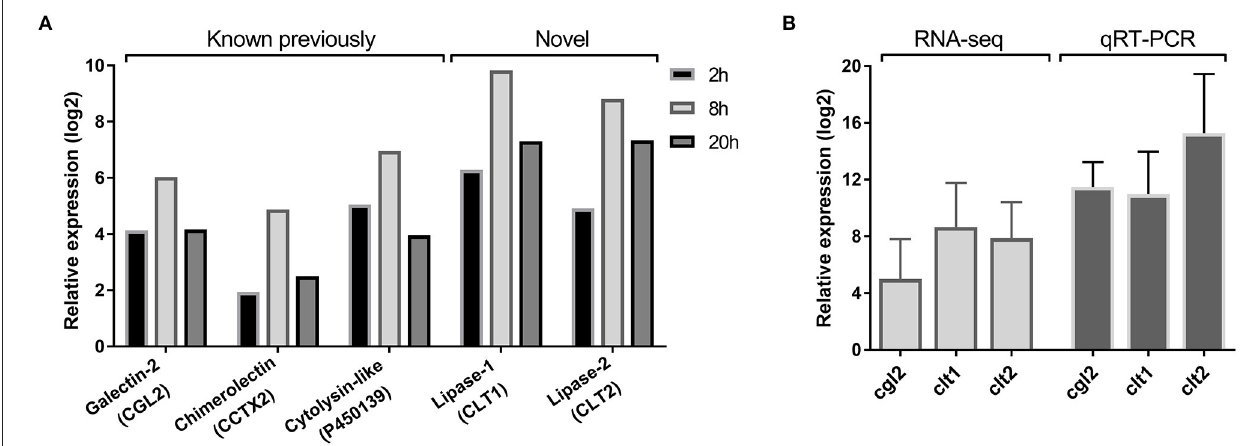
FIGURE 1 | Nematode-inducible defense proteins of C. cinerea. (A) RNA-seq based expression pattern of previously known and novel defense proteins of C. cinerea challenged by A. avenae for indicated time periods. Excluding CCTX2 at 2h, all genes were significantly differentially upregulated (log2 Fold Change > 2, False Discovery Rate < 0.05) in nematode-treated samples compared to the control samples. (B) Expression of novel defense proteins along with CGL2 as a positive control validated with qRT-PCR. C. cinerea was challenged by A. avenae in a microfluidic device for 8h. Error bars represent the standard deviation of three biological